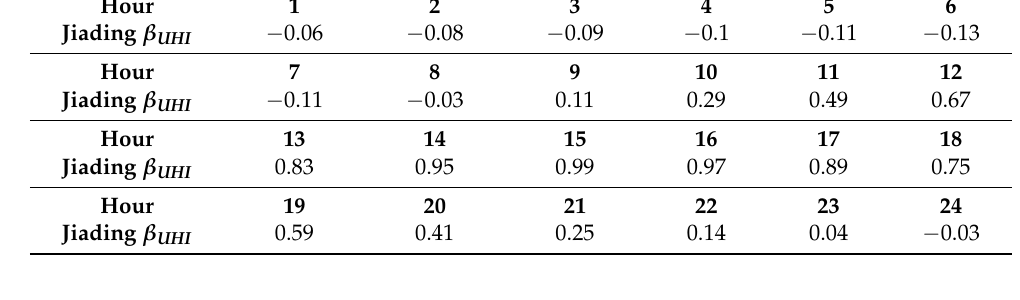
Table 15. Hourly variation coefficient of dry bulb temperature in Jiading.